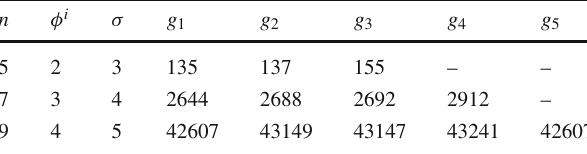
Table 2 Number of graphs computed for the renormalization of the field and each coupling constant for O ( N ) symmetric theories for